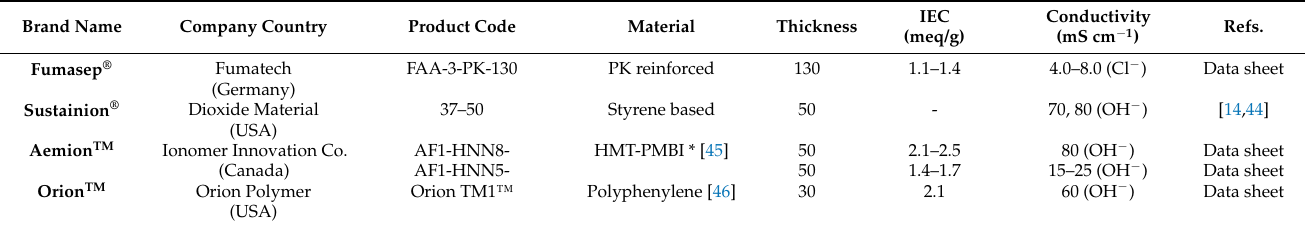
Table 1. Commercial AEM